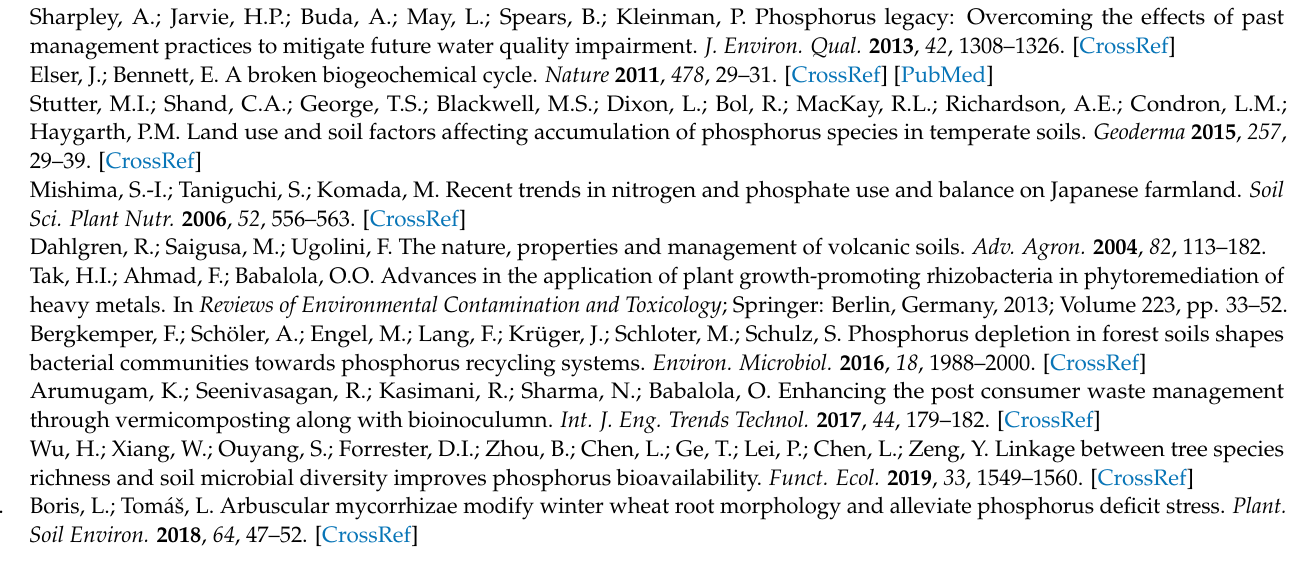
Figure S4: Principal coordinate analysis of the archaeal genus abundant in the maize rhizosphere under fertilization and control conditions. Table S1: Quantity of microbial phosphorus cycling genes present in the rhizosphere soil